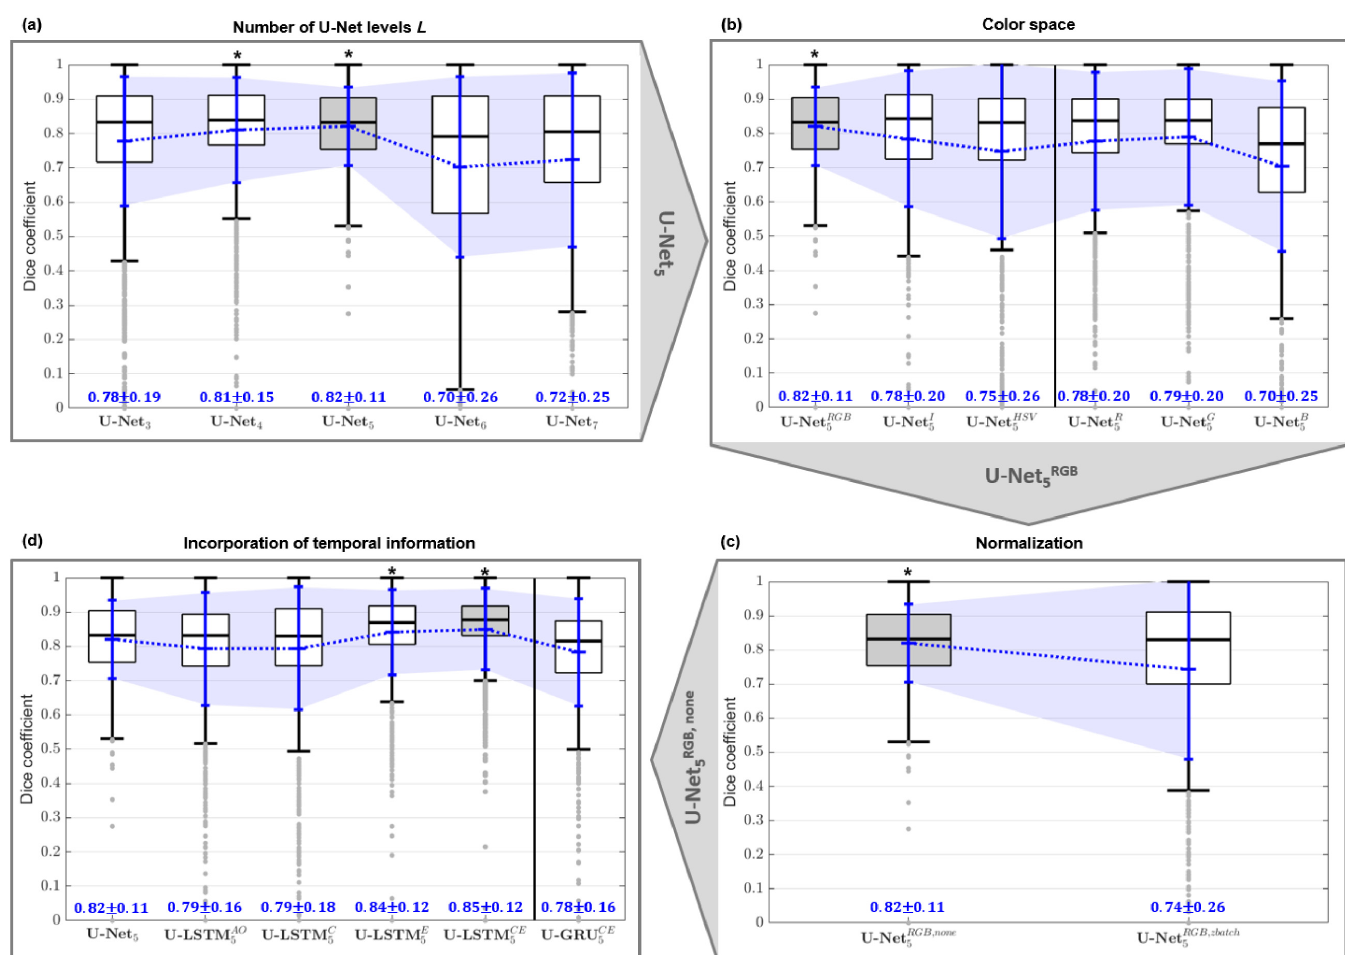
Fig 4. Identification of the best performing network architecture based on a hierarchical selection strategy. Impact of (a) number of U-Net levels, (b) color space representation, (c) normalization, and (d) positioning of C-BLSTM layers and GRU cells. Results show the distribution of the Dice Coefficients obtained from 1,500 test images. Mean DC indicated by blue ‘+’. The best performing configuration is highlighted in gray.